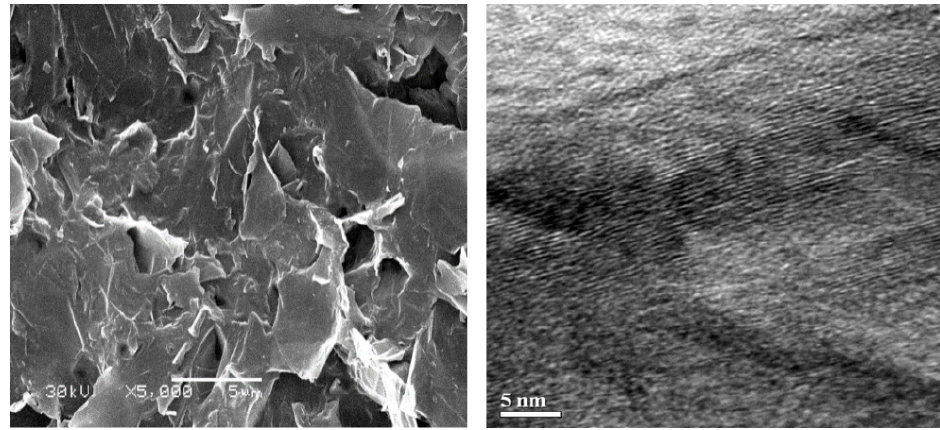
Figure 1. SEM images of basic and lateral surfaces of multilayered graphene particles.